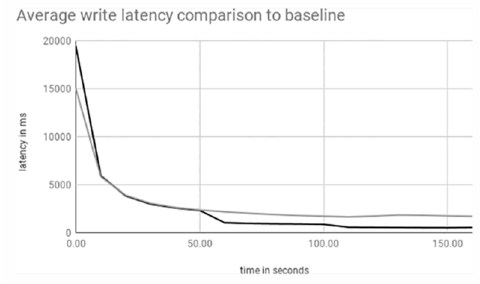
Figure 23. Average write latency of twice scaled cluster versus the baseline, single shard cluster.